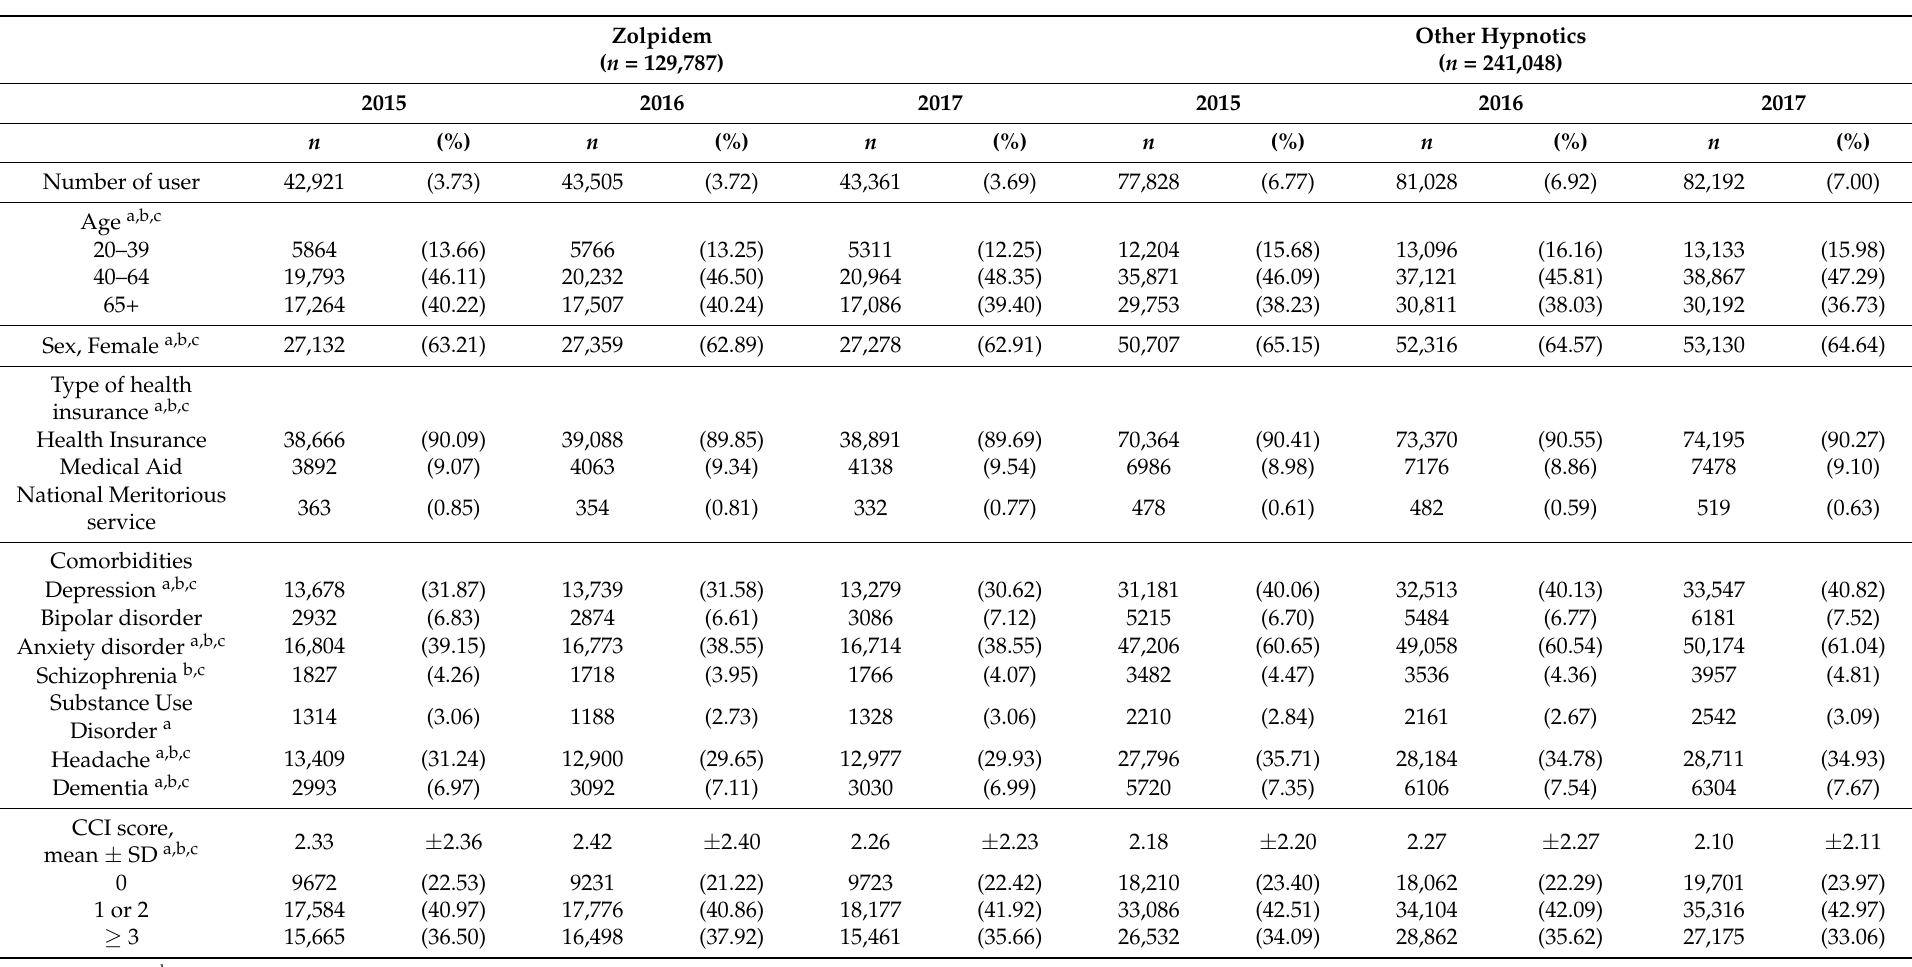
Table 1. Baseline characteristics of patients who used zolpidem or other hypnotics as outpatients from 2015 to